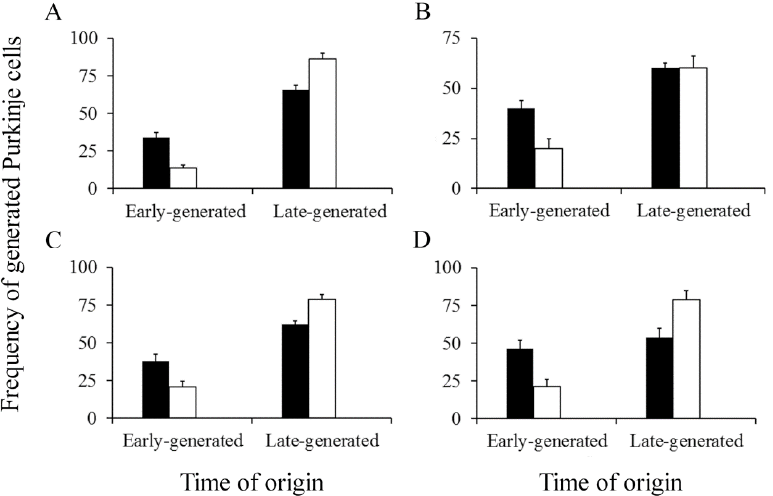
Figure 8. Percentage of early and late-produced Purkinje cells scored at the level of the vermis ( A ), paravermis ( B ), medial ( C ), and lateral hemispheres ( D ). Black columns indicate animals injected with bromodeoxyuridine and white columns animals administered with [ 3 H]TdR. Values are expressed as mean ± SEM.